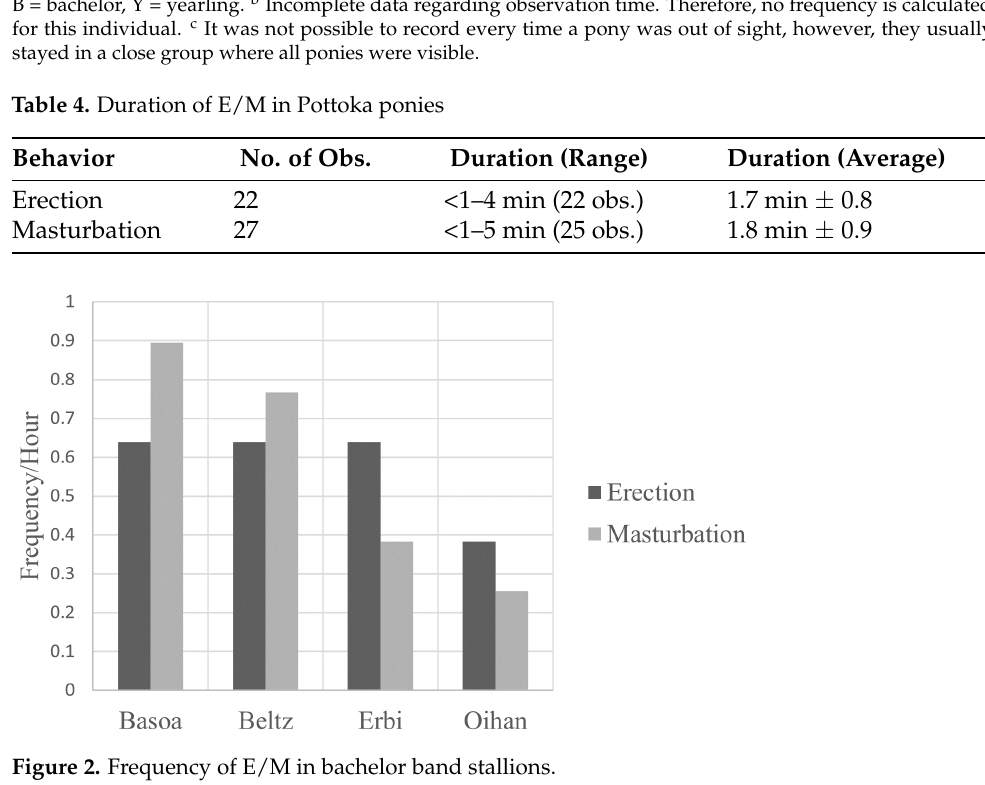
Figure 2. Frequency of E/M in bachelor band stallions.